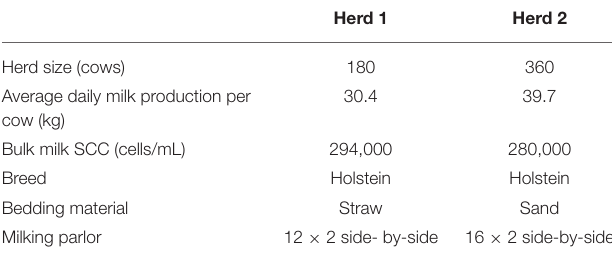
TABLE 1 | Key characteristics of the two study